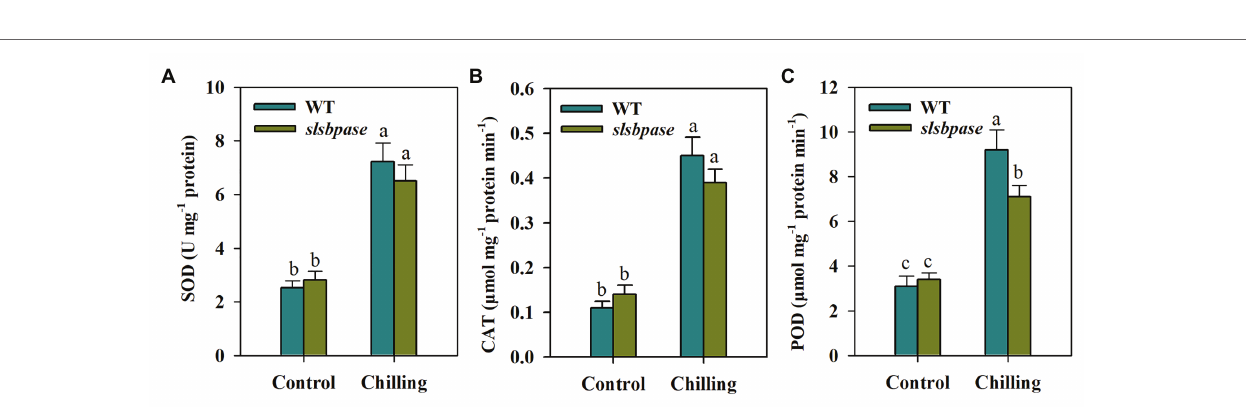
FIGURE 3 | Activities of antioxidant enzymes were differentially affected by SlSBPASE mutation in chilling-stressed tomato plants. (A) Superoxide dismutase (SOD); (B) catalase (CAT); and (C) peroxidase (POD). At the fourth-leaf stage, slsbpase mutants and wild-type plants were subjected to a 24 h chilling stress. Following that, leaves from different groups were sampled for the determination of enzyme activities. The results are mean values ± SDs from three independent experiments, and different letters on top of each column represent significantly different values at p < 0.05 among